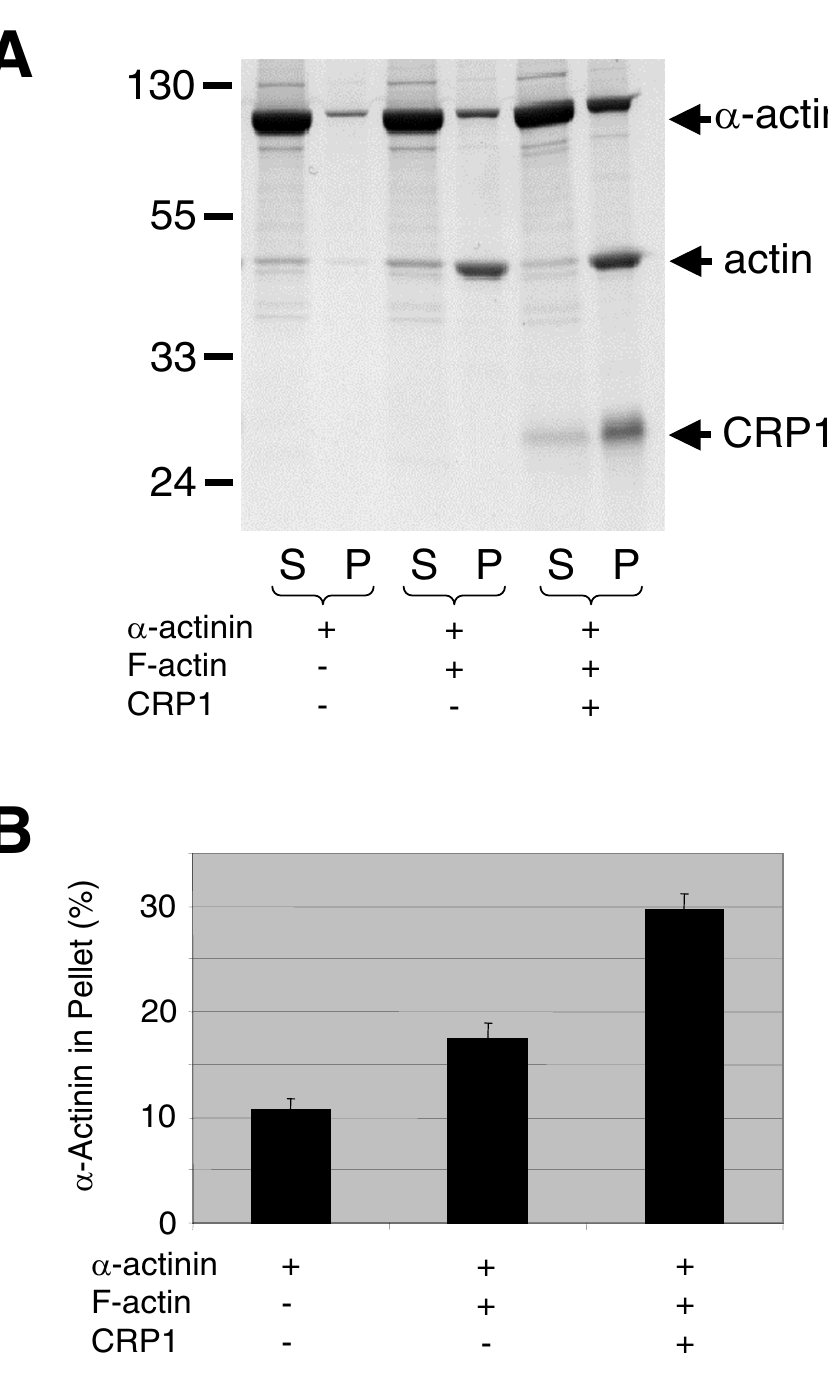
Figure 3 CRP1 stabilizes the interaction of α -actinin with actin bundles . Actin filaments were bundled by incubation with α - actinin for 30 min. at room temperature. CRP1 was then added, incubated for an addition 30 min., and centrifuged at 10,000 × g. Proteins from the supernatant (S) and the pellet (P) were separated by electrophoresis and detected by Gelcode Blue stain- ing ( A ). The percentage of total α -actinin in the pellet was quantified as described in Experimental Procedures ( B ). n = 3 ±